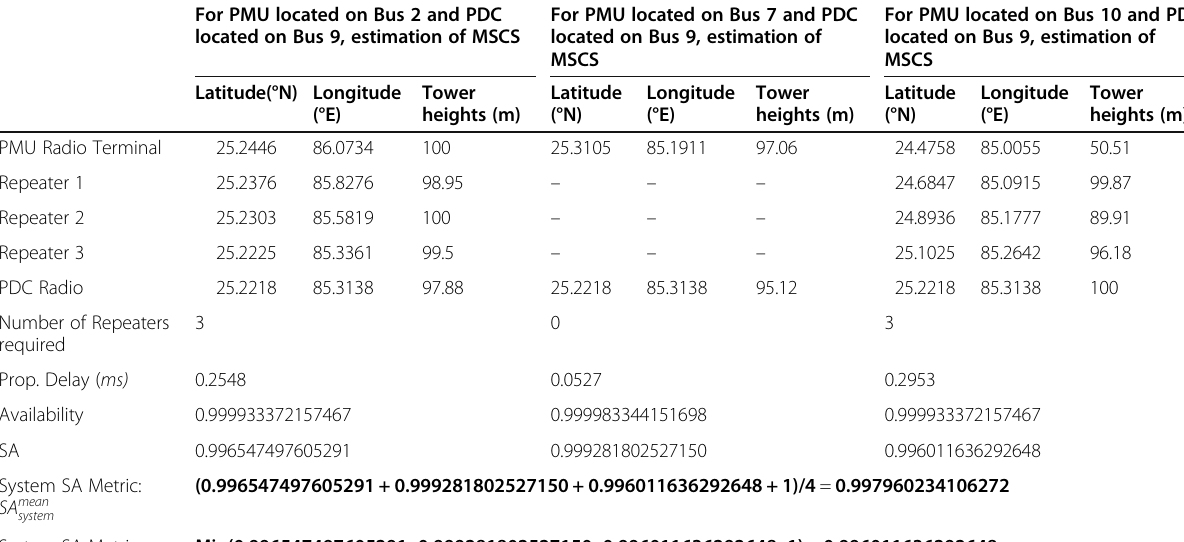
Table 4 Case study results without ZIB measurements For PMU located on Bus 2 and PDC located on Bus 9, estimation of